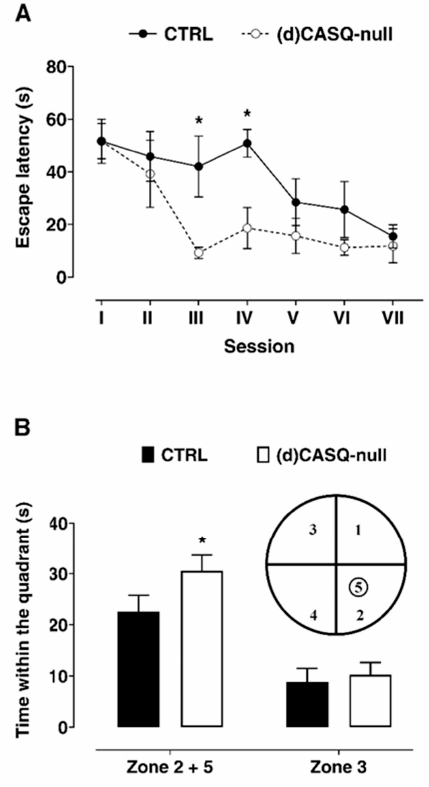
Figure 6. Evaluation of spatial learning using the Morris Water Maze paradigm. ( A ) Latency to reach the platform calculated considering the first trial of every session; each point represents the mean value ( ± S.E.M.) of all animals used. Two-way ANOVA test: session F(6, 68) = 5.7, p < 0.01; between animal groups F(1, 8) = 13.67 p < 0.01; Sidak’s multiple comparisons test * p < 0.05. ( B ) Probe test performed one day after the end of the training evaluated as the permanence time of the animal in the platform quadrant. Two-way ANOVA test: zone F(1, 8) = 20.06 p < 0.01; between animal groups F(1, 8) = 11.73, p < 0.01; Sidak’s multiple comparisons test * p < 0.05. n = 5 animals in both the CTRL and (d)CASQ-null mice.